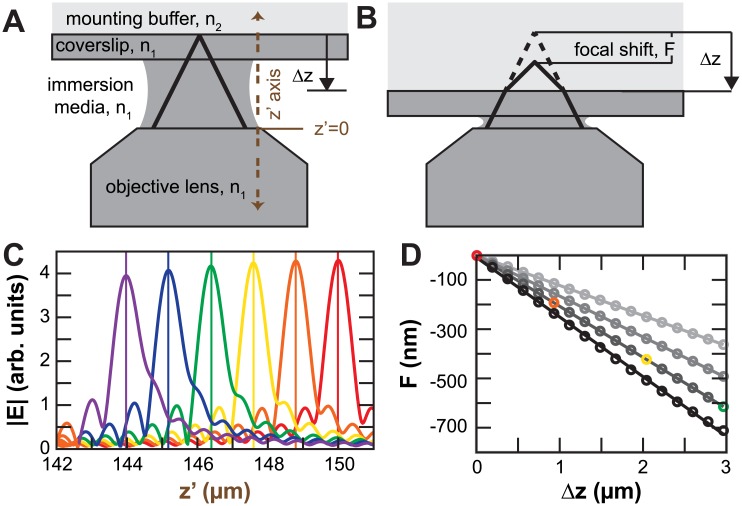
Schematic of idealized imaging system and focal shift.(A,B) When the sample and the objective have difference refractive indices, moving the sample closer to the objective does not move the effective focal plane the same distance. Brown dashed line indicates the z’ axis and z’ = 0 at the surface of the objective. In this schematic, F and ΔZ have opposite signs, corresponding to a situation of n
2 < n
1. (C) Plots of intensity of electric field along the optical axis z’ for different positions of the n
1 − n
2 interface (Eq 1, NA = 1.2). Colors indicate sample positions from 150 μm (red) through 147 μm (green) to 145 μm (purple). (D) Focal shifts are proportional to sample displacements. Colored circles refer to peak positions from panel C. Darker grays indicate larger NAs (0.13, 1.0, 1.2, 1.3).